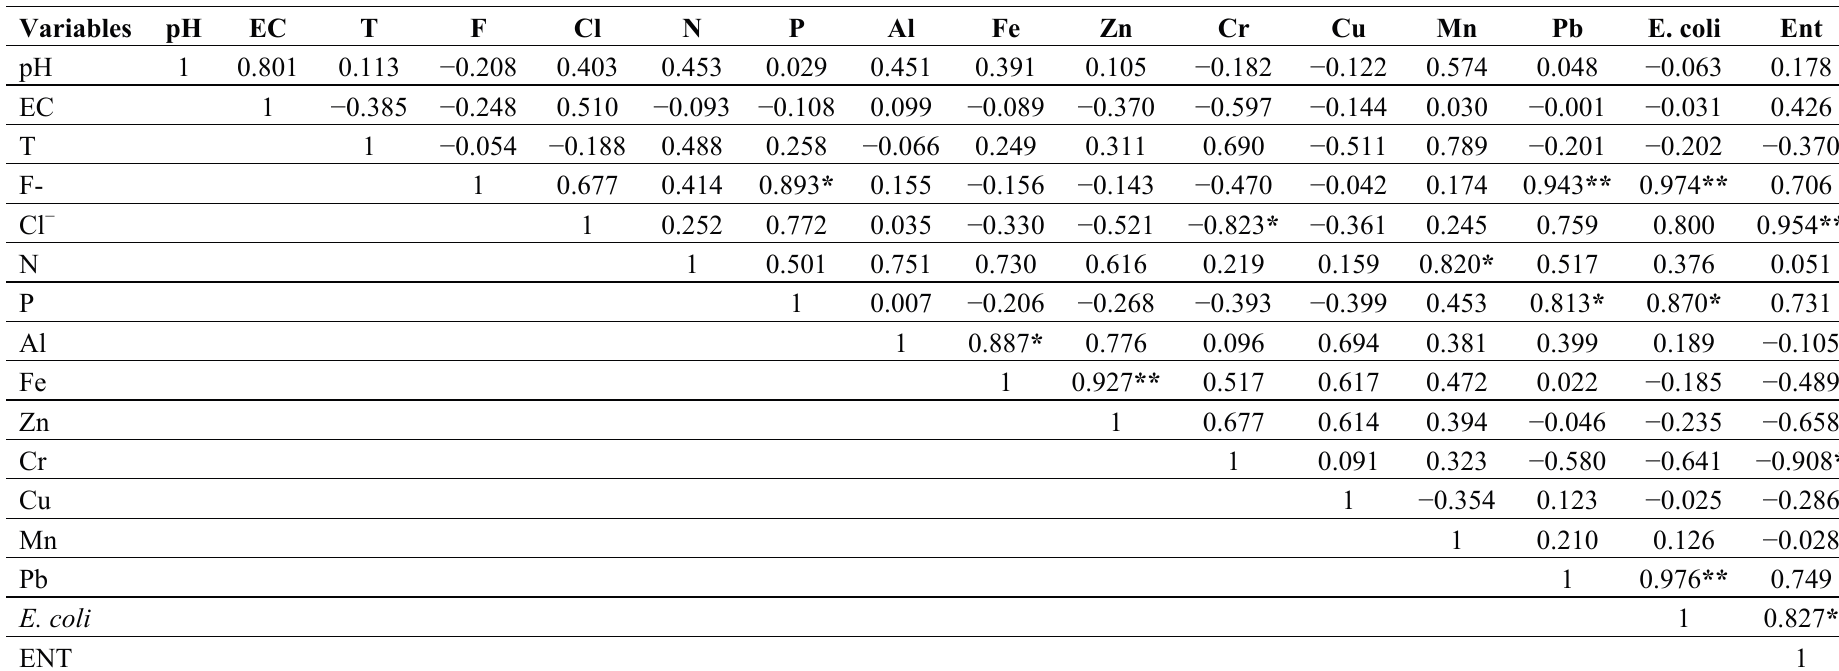
EC is electrical conductivity, T is turbidity, N is nitrate nitrogen, P is phosphate, Ent is enterococci ; * correlation is significant at 0.05 level (2-tailed); ** correlation is significant at 0.01 level